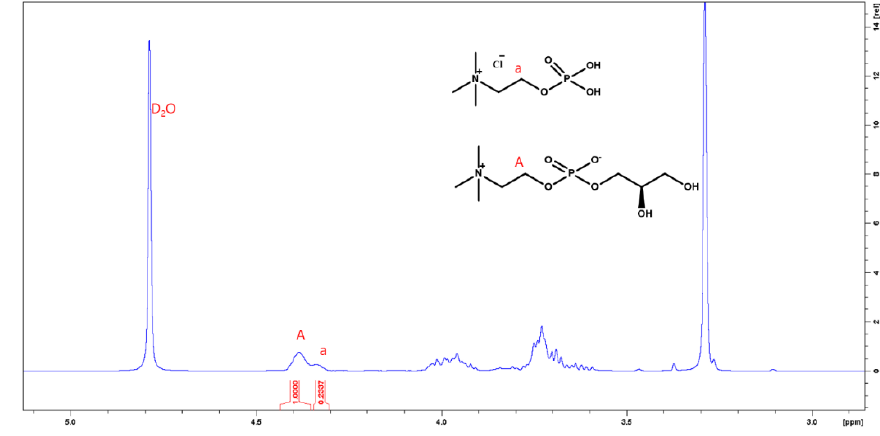
Figure 1. 1 H NMR spectrum of entry 4-4 .